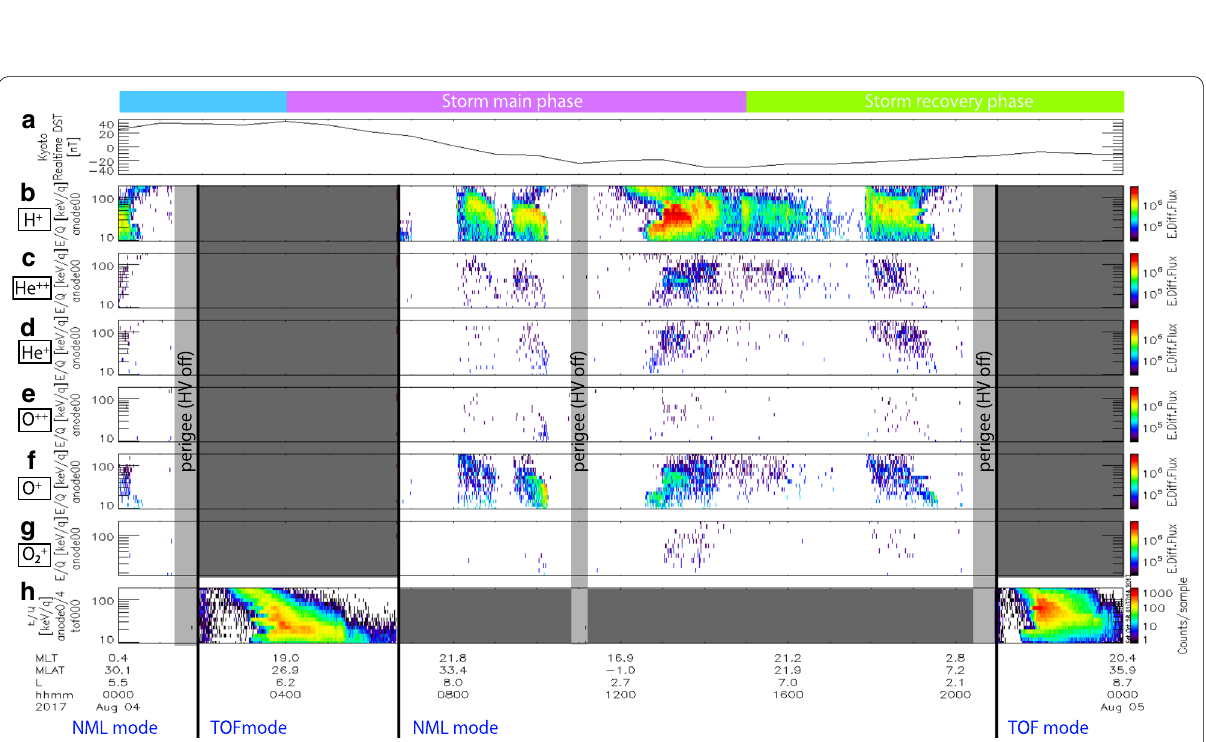
Fig. 11 One-day plot of the MEP-i observation on 4 August 2017; a Dst index, b – g energy/charge ( E/q )-time spectrograms of H + , He ++ , He + , O ++ , O + , and O 2 + obtained in the Normal mode, and h E/q -time spectrogram of all ion species in the TOF mode. The colors indicate the energy differen- tial flux (keV/cm 2 sr keV